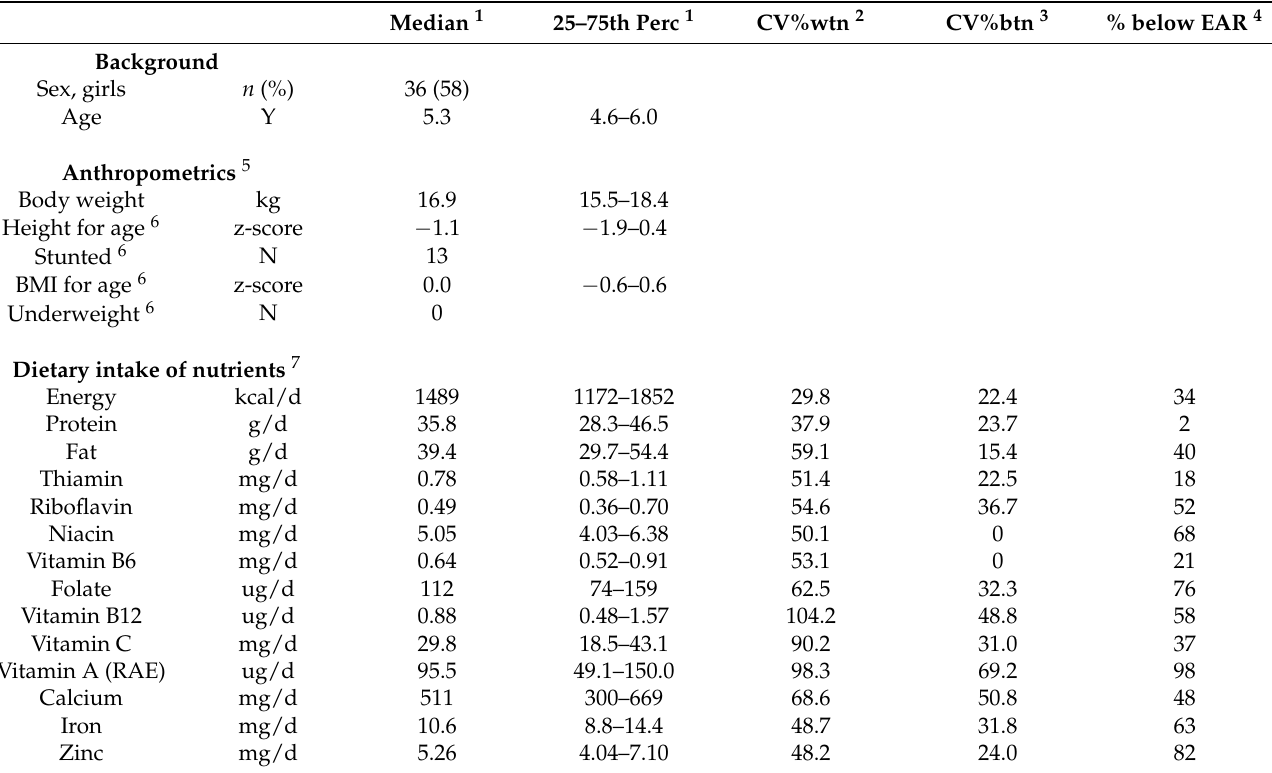
Table 2. Characteristics of the Kenyan children in the study population ( n = 62) including median intake per day and coefficients of variation for energy and the nutrients of interest 1